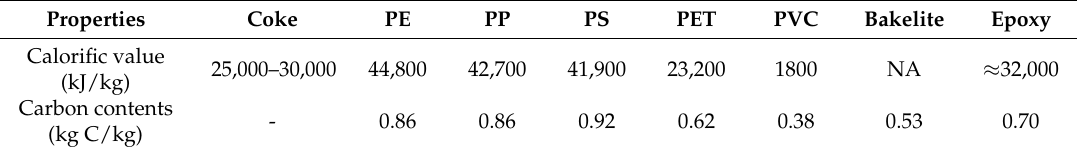
Table 5. Properties of resins